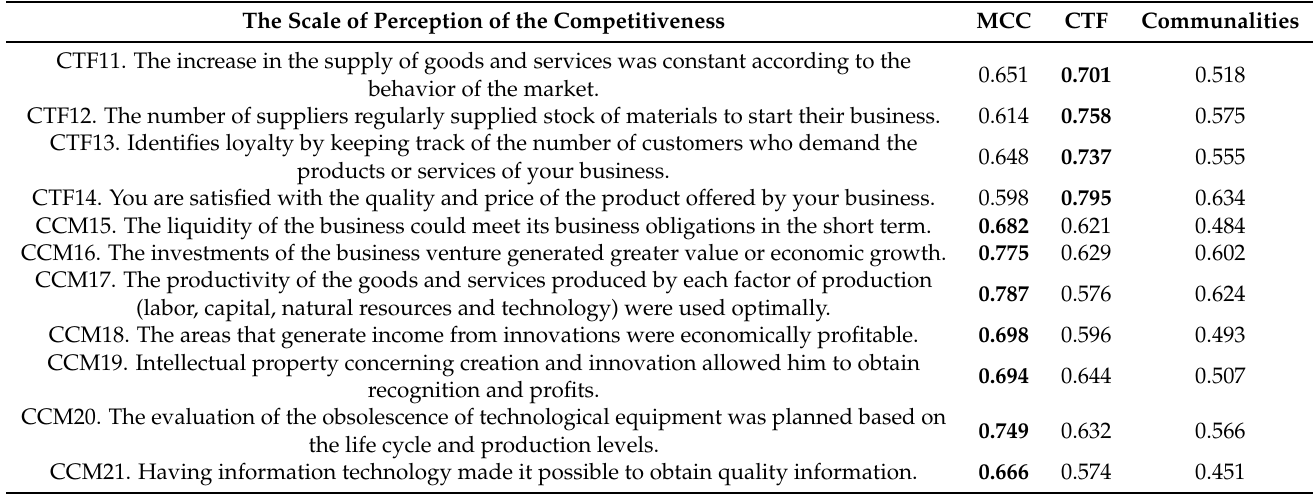
Table 3. Exploratory factorial analysis for Competitiveness Perception ( n =